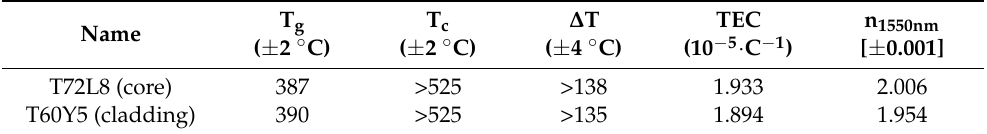
Table 4. Properties of the different glasses involved in the fabrication of a multimode step-index tellurite fiber.